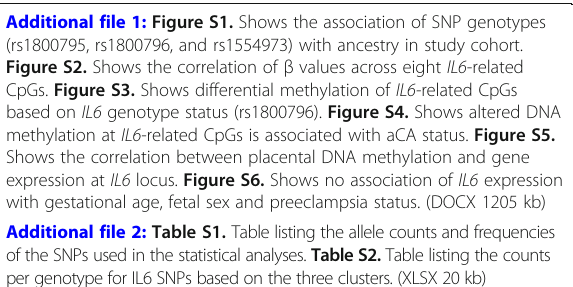
Figure S2. Shows the correlation of β values across eight IL6 -related CpGs. Figure S3. Shows differential methylation of IL6- related CpGs based on IL6 genotype status (rs1800796). Figure S4. Shows altered DNA methylation at IL6- related CpGs is associated with aCA status. Figure S5. Shows the correlation between placental DNA methylation and gene expression at IL6 locus. Figure S6. Shows no association of IL6 expression with gestational age, fetal sex and preeclampsia status. (DOCX 1205 kb) Additional file 2: Table S1. Table listing the allele counts and frequencies of the SNPs used in the statistical analyses. Table S2. Table listing the counts per genotype for IL6 SNPs based on the three clusters. (XLSX 20